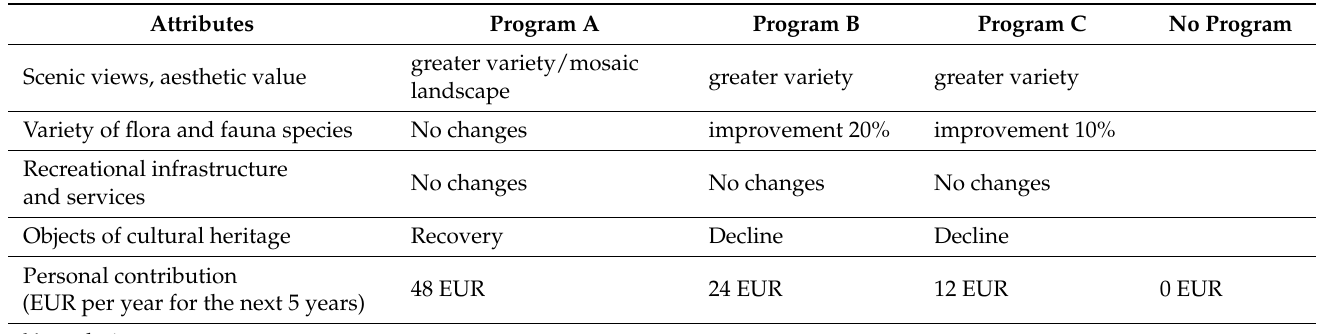
Table 2. Example of a choice card from the